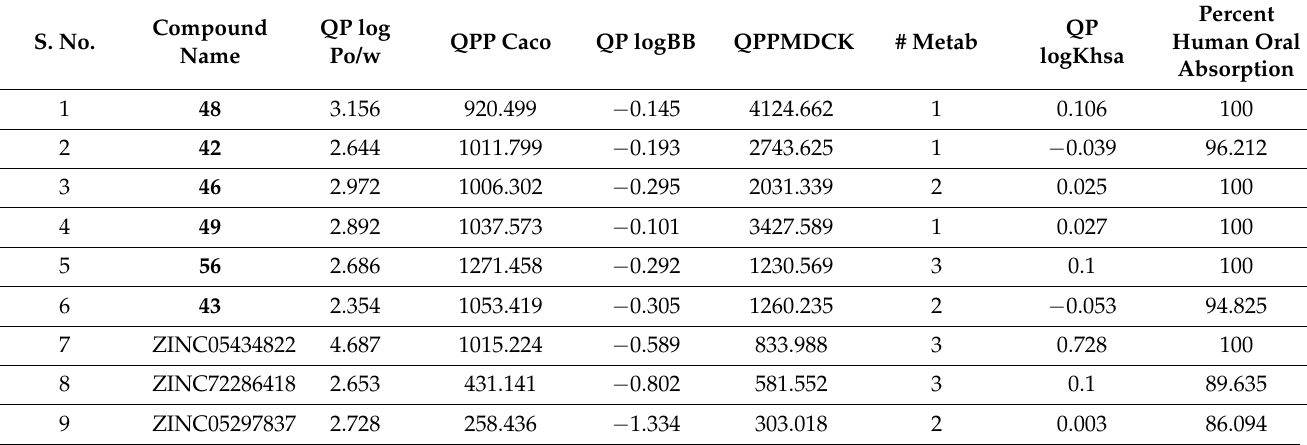
Table 8. ADME predictions of ZINC database and other active compounds. Predicted 1: Octanol/water partition coefficient;